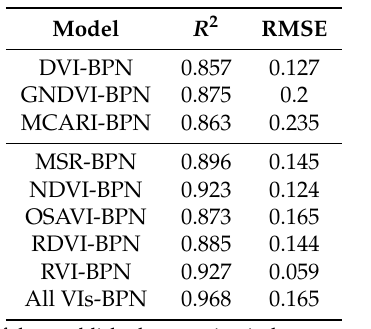
Table 5. Comparative analyses of the accuracies of the backpropagation (BP) neural network models for di ff erent input